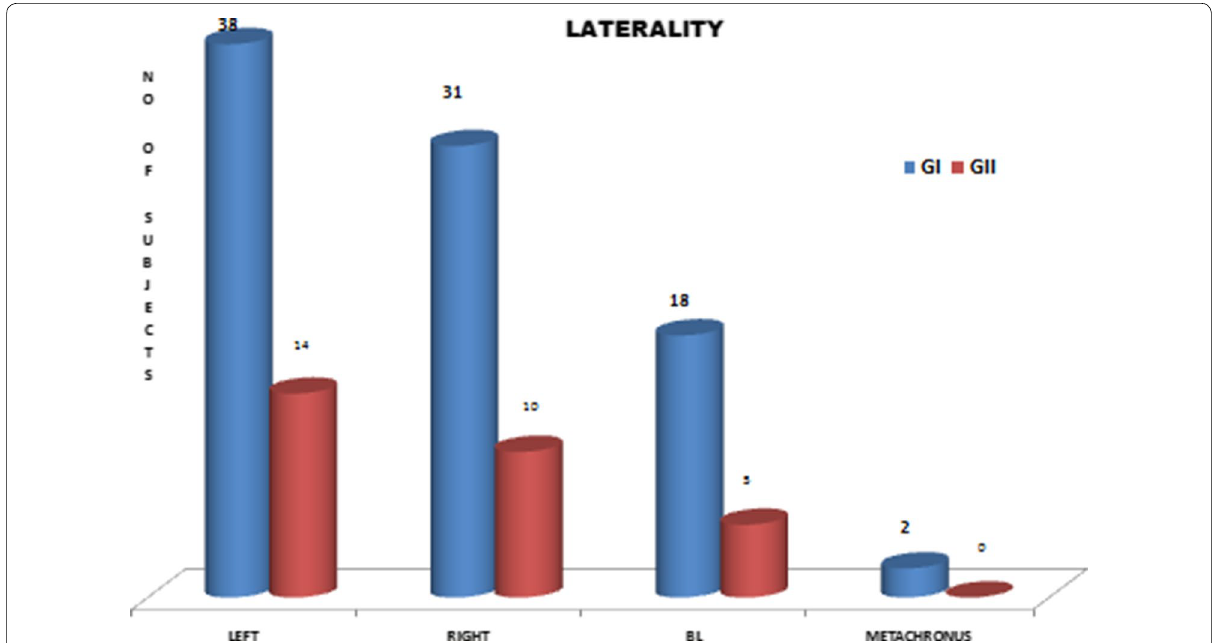
Fig. 3 Bar chart showing laterality of inguinal hernia in study subjects